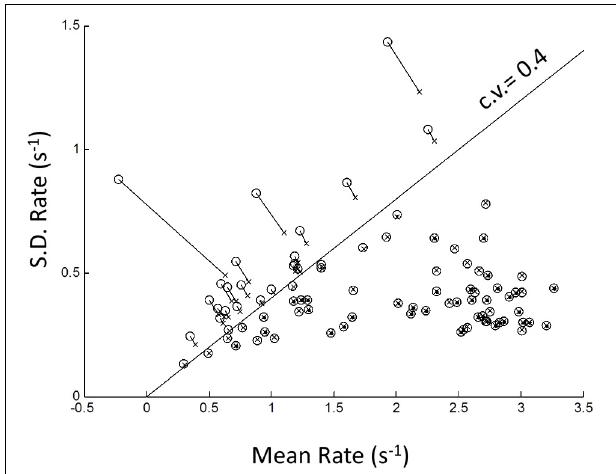
FIGURE 4 | Plot of standard deviation vs. mean of all blocks in the rate-domain. Crosses indicate conventional sample moments (same as top-right panel in Figure 3 ). Circles indicate maximum likelihood estimates (MLE) of same blocks assuming a left truncated Normal. Line is SD = Mean/2.5. To the right of line sample moments coincide with rectrN MLE moments; to the left MLE moments shift to higher standard deviations and lower means (connecting